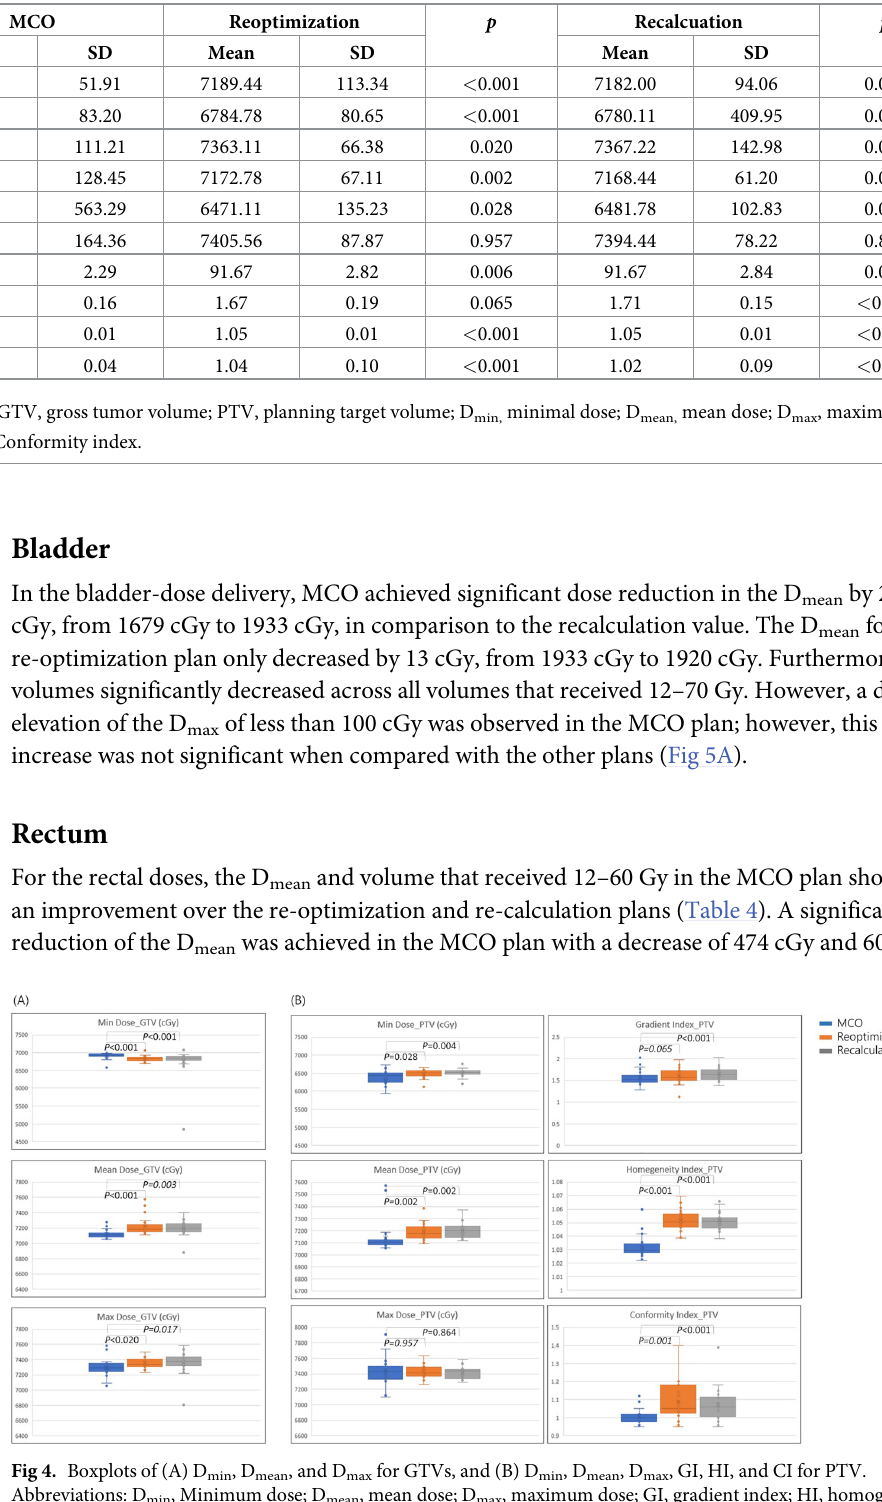
Table 3. Dose–volume statistics of target coverage with the GTV and PTV.